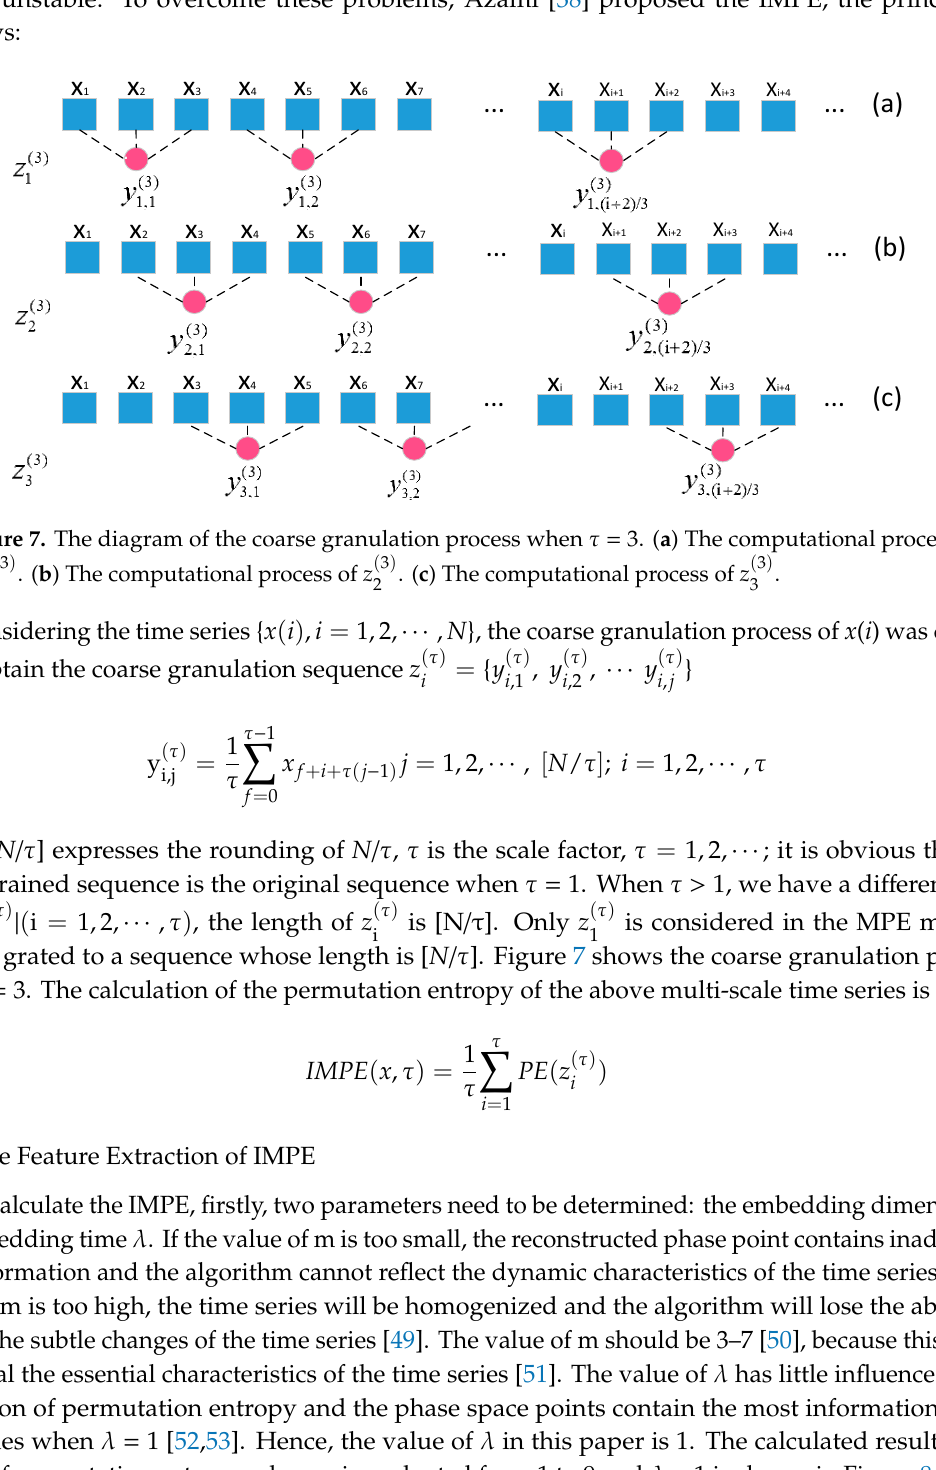
Figure 8. The curve of the calculated value of permutation entropy changing with the embedded dimension. Table 2. The permutation entropy of different load types during normal operations and serial arc fault conditions.